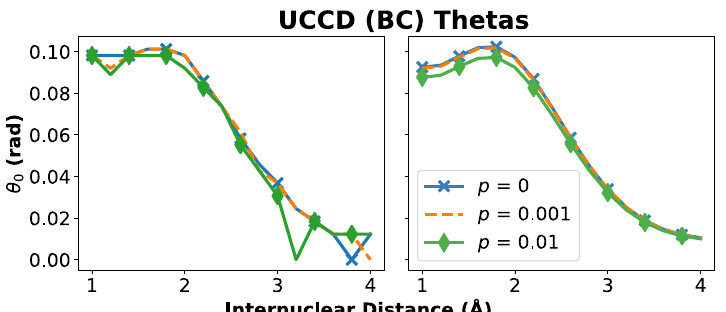
Fig. 3 The optimal parameters for the ground state energy of the bare UCCD ansatz found using the COBYLA (left) and L-BFGS (right) optimizers